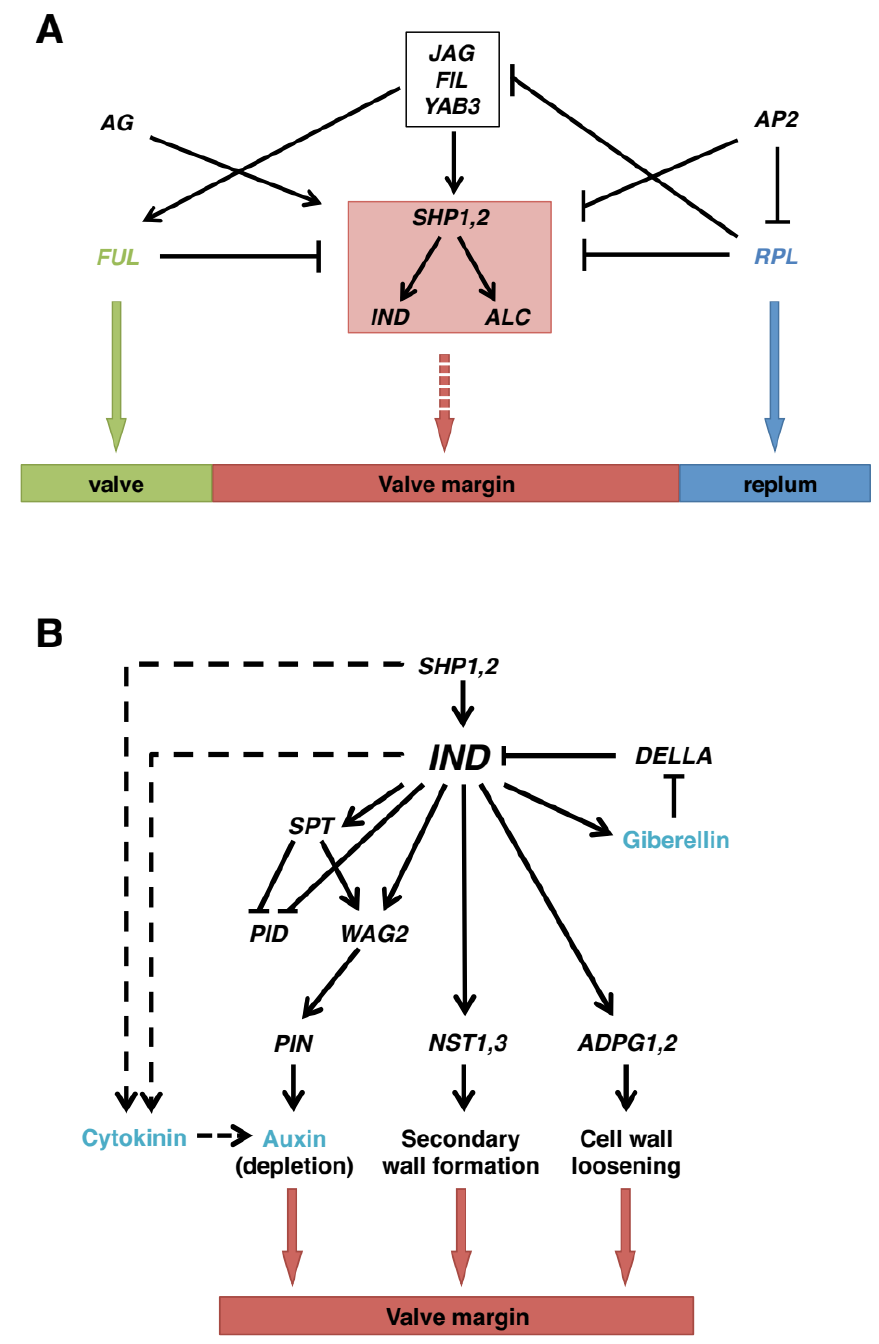
Figure 3. Molecular pathways involved in silique dehiscence in Arabidopsis . ( A ) Upstream transcription factors regulating dehiscence in Arabidopsis . Green color indicates valve, blue color indicates replum, and red color indicates valve margin identity related genes and processes. Dashed arrow indicates indirect downstream effect. ( B ) Regulatory pathways downstream of the transcription factor IND (Indehicient). Cyan color indicates hormones involved in shattering. Dashed arrows indicate indirect effect.